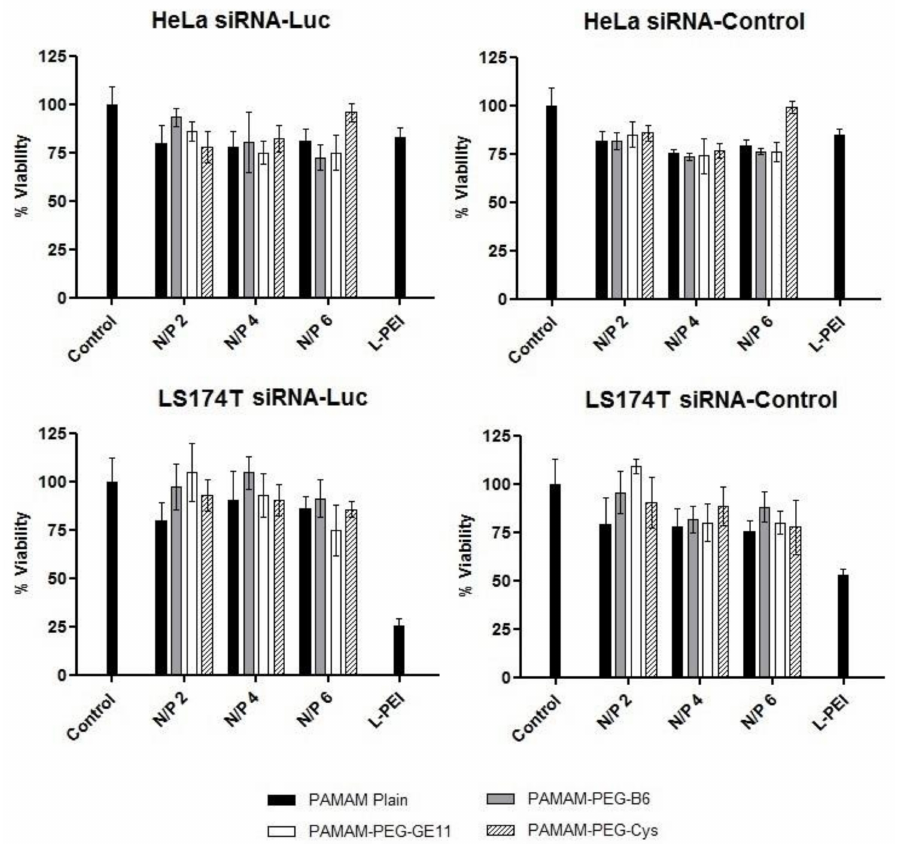
Figure 2. Viability of HeLa and LS174T cells. LPEI (polyethylenimine) polyplexes, PAMAM-plain and targeted PAMAM conjugates with specific siRNA-Luc or siRNA-Control were applied at different N/P ratios. Non-treated cells were included as control. Data are expressed as the mean ± SD ( n =